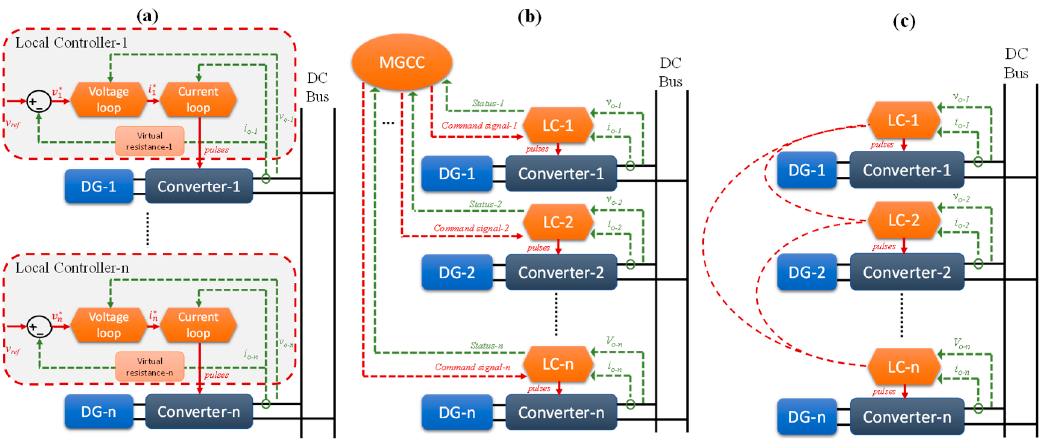
Figure 4. Examples of: ( a ) decentralized droop control, ( b ) centralized control, and ( c ) distributed communication-based control.